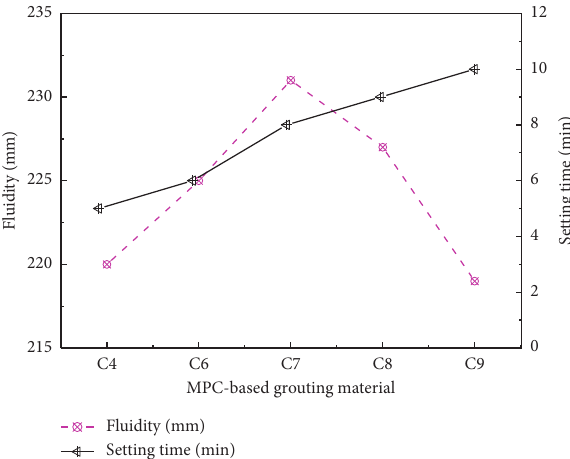
Figure 5: The fluidity and setting time of the fresh MPC-based grouting material with different additions of